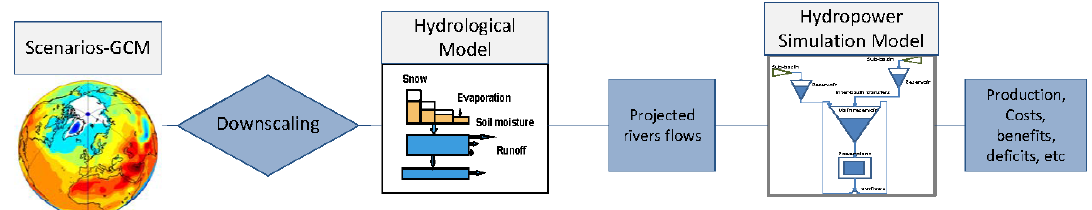
Figure 3. Main steps and methods used in assessing the impacts from future climate scenarios to hydropower production in Zambezi River.